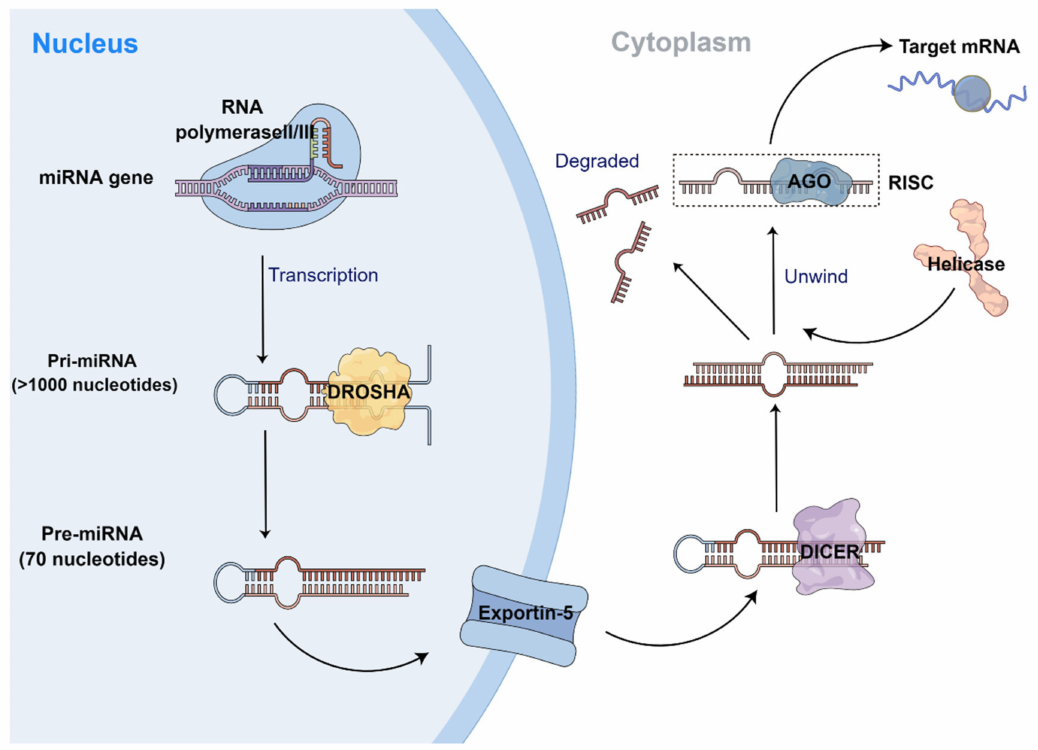
Figure 1. Schematic diagram of synthesis and processing of miRNAs. The gene of the miRNA is transcribed into a pri-miRNA under the mediation of RNA polymerase II/III and then cut into the pri-miRNA by DROSHA; subsequently, the pre-miRNA is transported by exportin-5 into the cytoplasm and cleaved by the endonuclease DICER; then, under the action of helicase, two single strands are formed, one of which forms RISC with AGO, and the other is